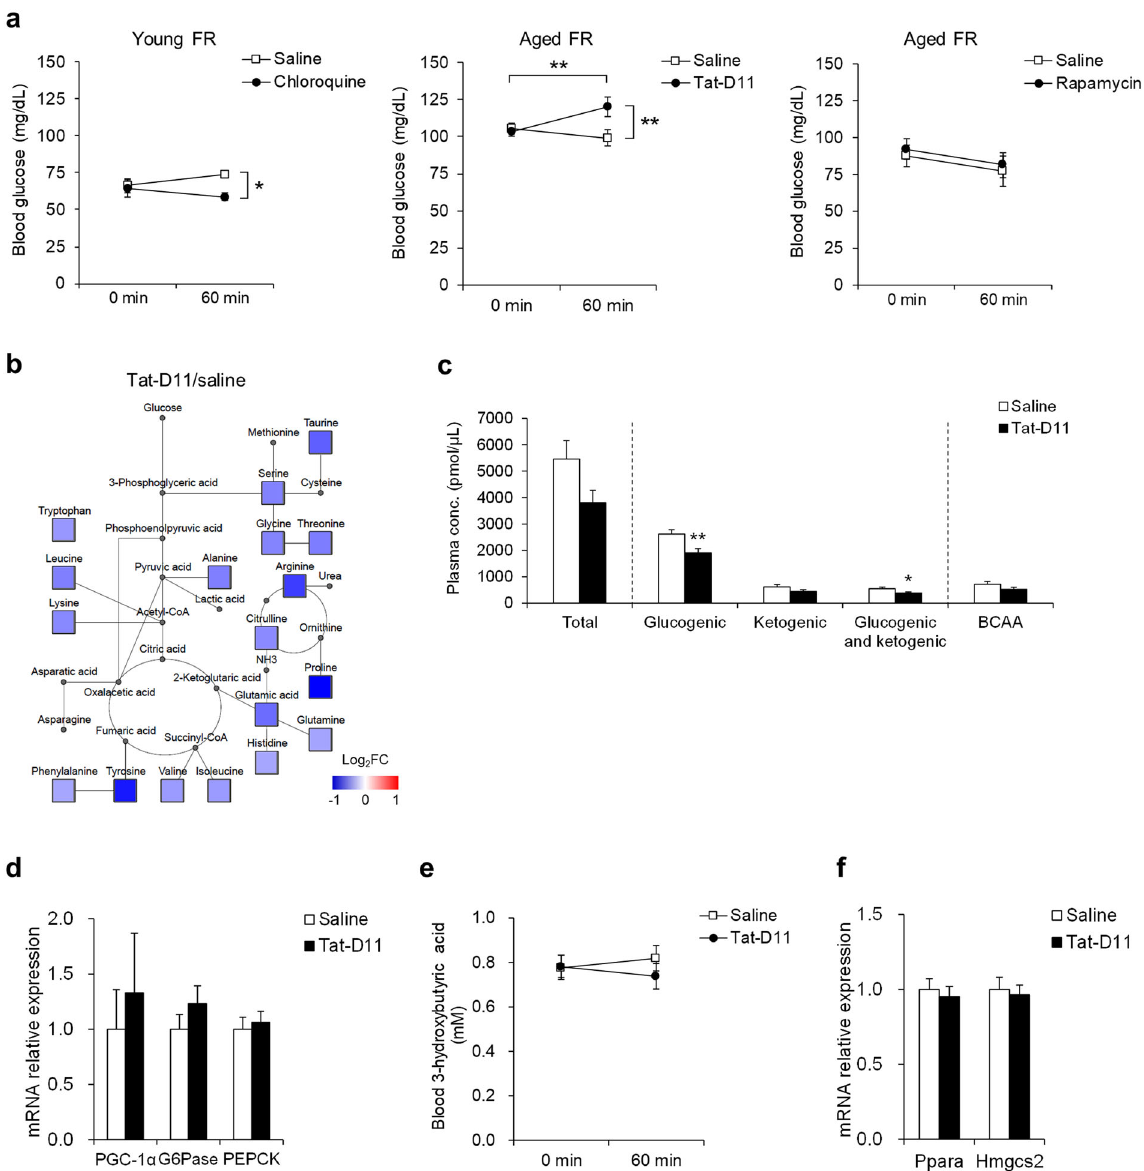
Fig. 6 Effect of autophagy modulators on day 5 of food restriction. a Blood glucose levels after injection of chloroquine in young food- restricted (FR) mice (left panel; saline n = 4, chloroquine n = 5), after injection of Tat-Beclin1 D11 autophagy-inducing peptide (Tat-D11) in aged FR mice (middle panel; saline n = 17, Tat-D11 n = 16), and rapamycin in aged FR mice (right panel; saline n = 11, rapamycin n = 10). * P < 0.05, *** P < 0.001 by Bonferroni test. b Map of an amino acid metabolic pathway in aged FR mice at 60 min after Tat-D11 injection. Mean ratio of the plasma level of amino acids in Tat-D11-injected mice to that in saline-injected mice was shown in the color scale, where red and blue represented upregulation and downregulation compared to the mean value in saline-injected mice, respectively. Undetected amino acids and key metabolites are denoted with small gray circles. c The plasma concentration of the amino acids. d The gene expression of gluconeogenic- related peptides in the liver. e Blood β HB levels. f Gene expression of ketogenesis-related peptides in the liver 60 min after Tat-D11 injection in aged FR mice. * P < 0.05, ** P < 0.01 Comparison to the saline-injected mice by the Student ’ s t test; saline ( n = 17), Tat-D11 ( n = 16). Data are presented as mean ±